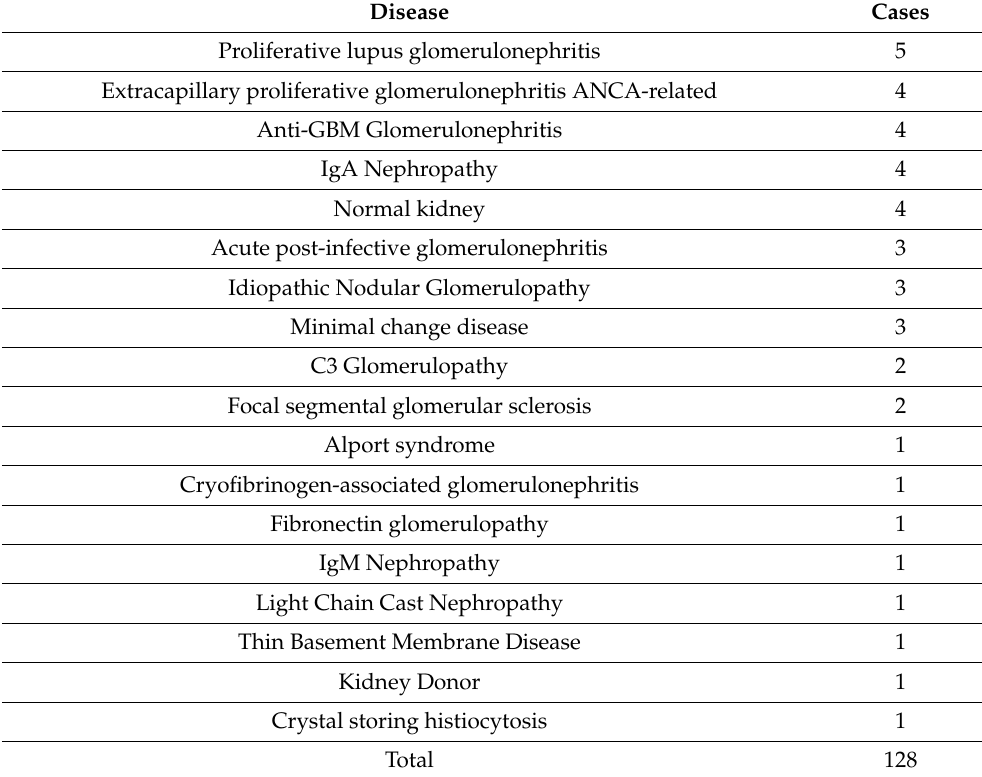
Table 1. Cont . Disease Cases Proliferative lupus glomerulonephritis 5 Extracapillary proliferative glomerulonephritis ANCA-related 4 Anti-GBM Glomerulonephritis IgA Nephropathy Normal kidney Acute post-infective glomerulonephritis Idiopathic Nodular Glomerulopathy Minimal change disease Focal segmental glomerular